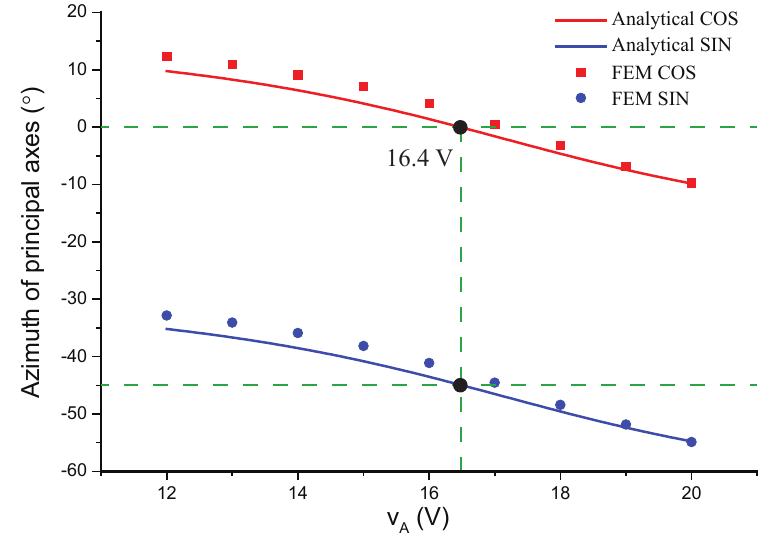
Figure 12. Analytical and FEM simulations of the azimuth of the principal axes under the control of v A